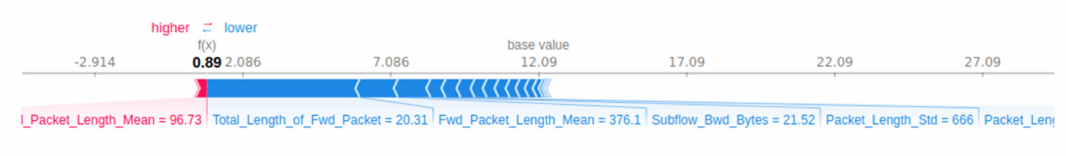
Figure 9. Explanation of a single prediction (10